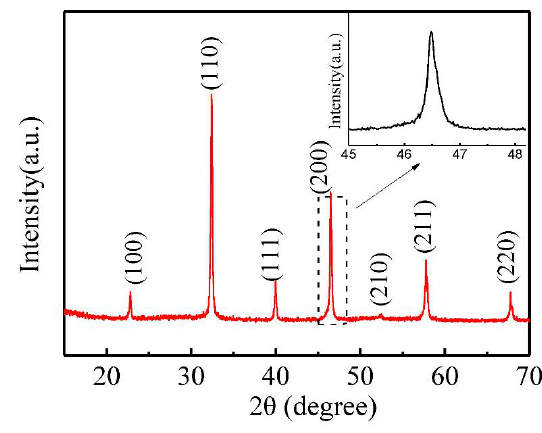
Figure 4. The XRD pattern of unpoled NBT-6BT-KNN crystal powder.